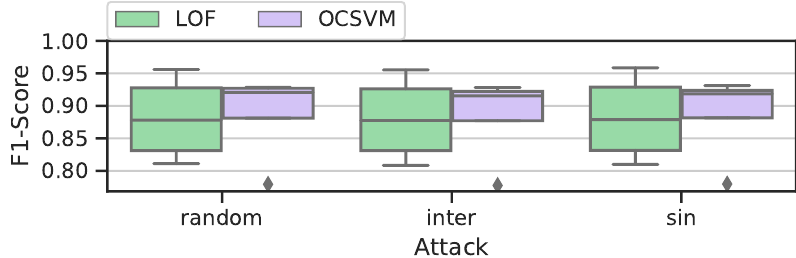
Figure 10. F1-Score variation of LOF and OCSVM grouped by attack